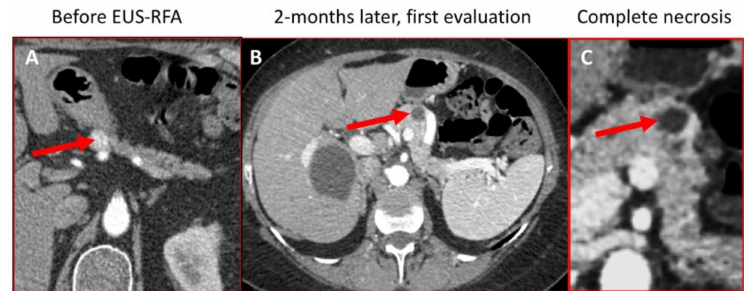
Figure 1. Following contrast enhancing PM with CT-scan before and after EUS-RFA. Abdomen CT- Scan with contrast injection at artery phase, before ( A ) and after endoscopic radiofrequency ablation of PM in the body of the pancreas, displaying complete response without contrast enhancement in RFA scar (( B ) and at magnification ( C )). PM: pancreatic metastases, CT: computed tomography, EUS-RFA: Endoscopic Ultra-Sound guided RadioFrequency Ablation.